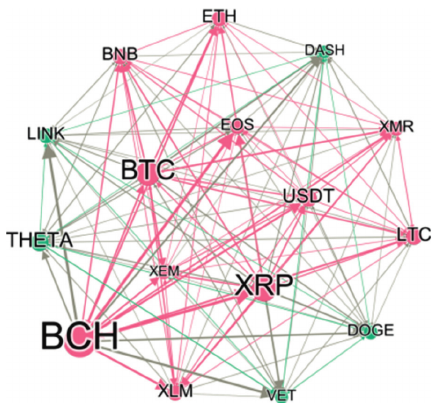
Figure 30: Risk spillover under